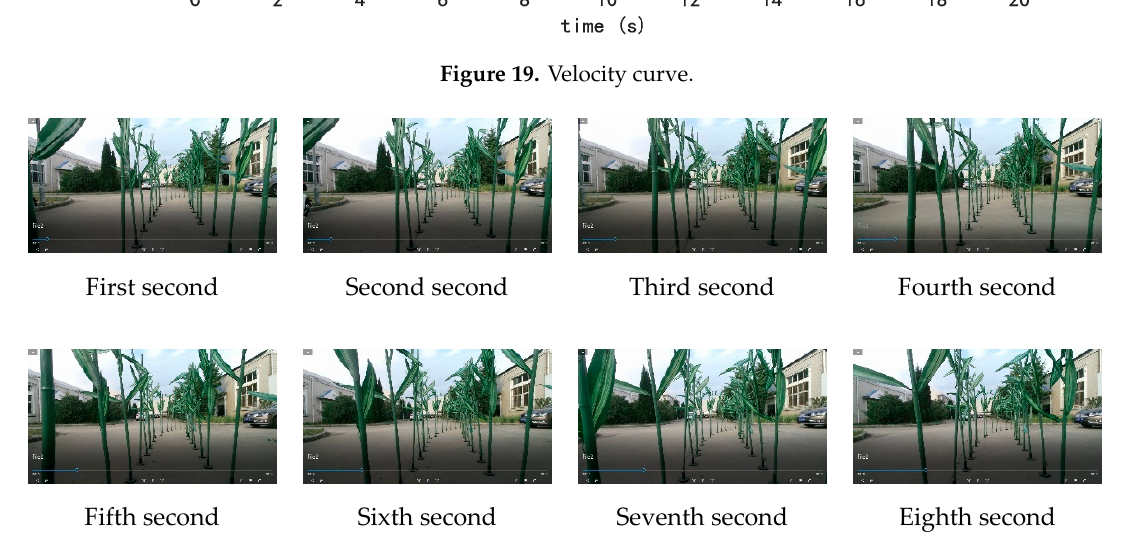
Figure 19. Velocity curve.